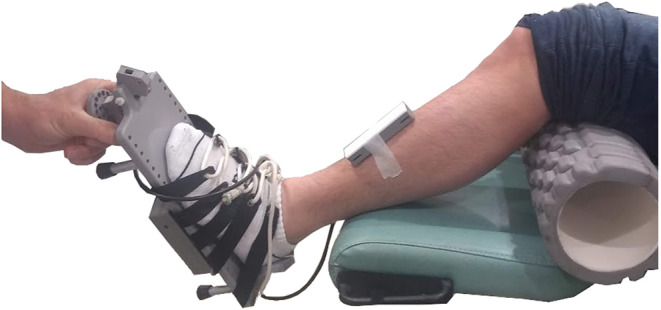
The custom-built electronic goniometer used to measure dorsiflexion range. The participant was placed in a supine position. An 11 cm diameter foam roller was placed under the knee. The experimenter rotated the foot through dorsiflexion until 10 Nm was reached. Dorsiflexion range was defined as the angle between an accelerometer placed on the tibia and an accelerometer placed underneath the sole of the foot at 10 Nm of torque. Ankle angles below 90° indicate plantarflexion and above 90° dorsiflexion.